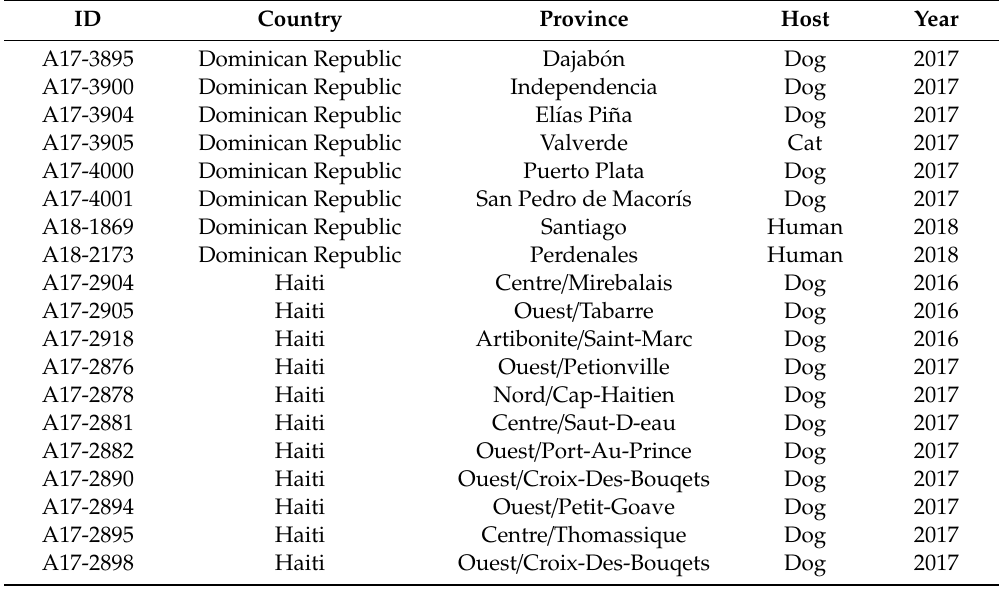
Table 1. Isolates of rabies virus (RABV) used in the phylogenetic analysis.